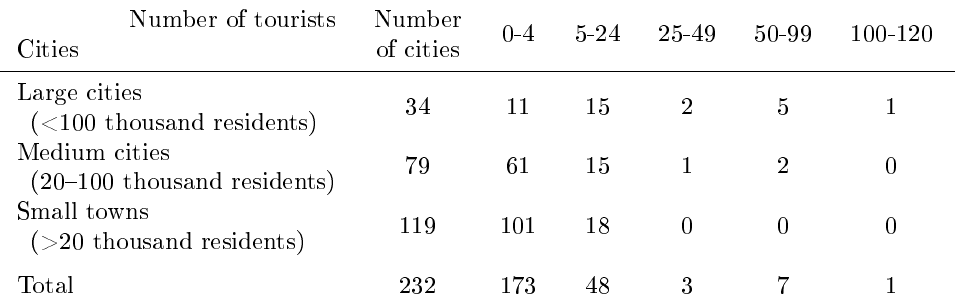
Table 1: Cities visited as part of urban tourism according to the size of the city center Number of tourists Number 0-4 5-24 25-49 50-99 100-120 Cities of cities Large